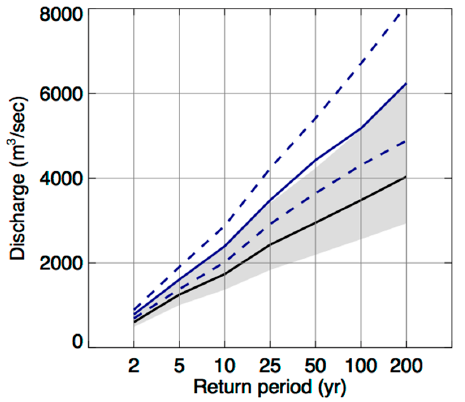
Figure 6. The black solid line and shaded area represent the estimated values and 5–95% confidence intervals of flows for different return periods obtained from the 19 climate projections in the period 1960–2009 in Cedar River at Cedar Rapids. The solid and dashed blue lines are the same for the period 1960–2099.